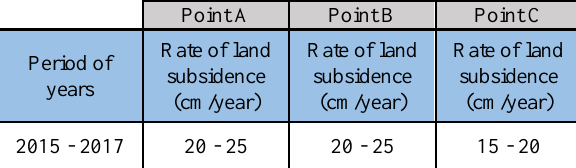
Table 2. Rate of land subsidence based on InSAR data at selected points (A, B, C)